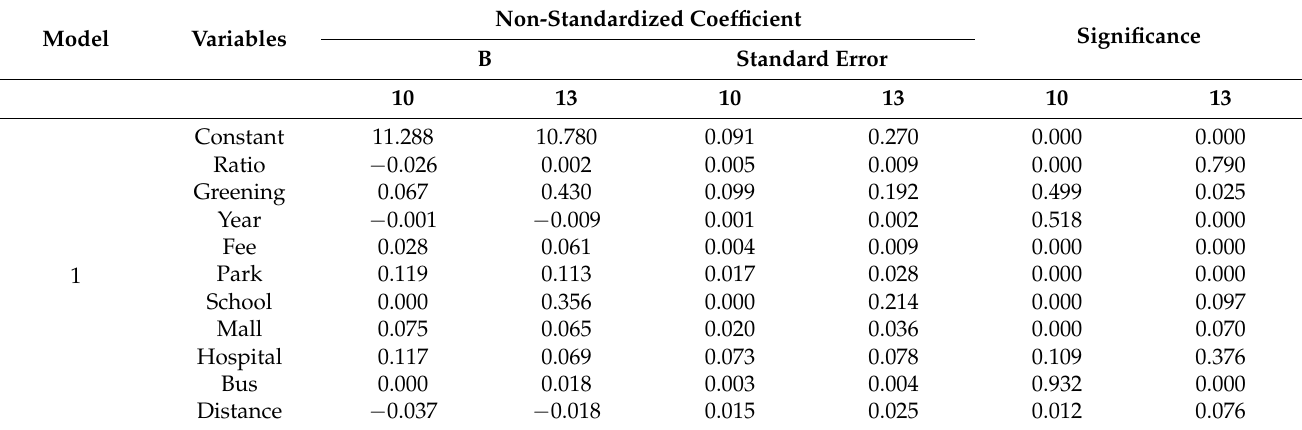
Table 2. Regression coefficients of Metro Line 10 and Line